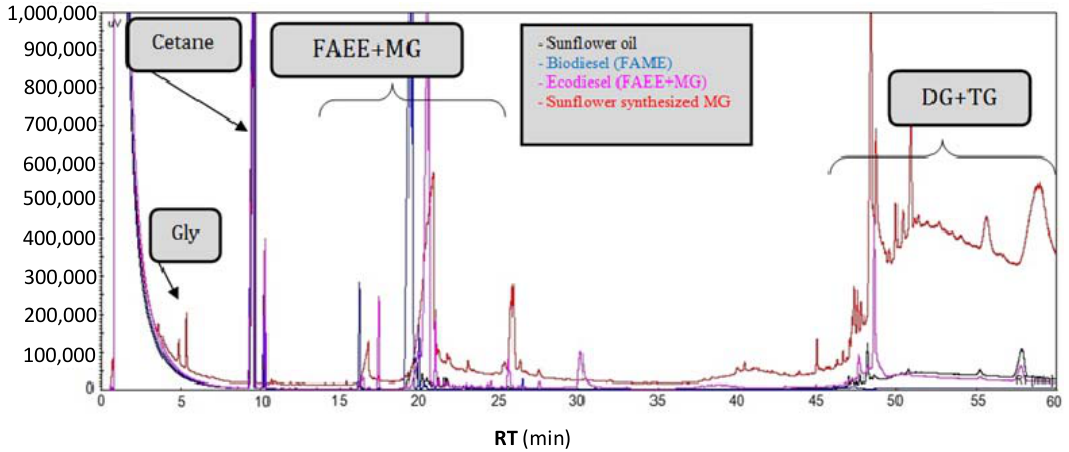
Figure 1. Superimposed chromatograms of sunflower oil (black), as well as obtained chromatograms in the alcoholysis of sunflower oil with methanol (FAME), ethanol (FAEE) and glycerol (monoglycerides, MGs) corresponding to blue, pink and red respectively. Selectivity is defined as the percentage of reaction products with retention times (RT ≤ 25) similar to those hydrocarbons that compose the